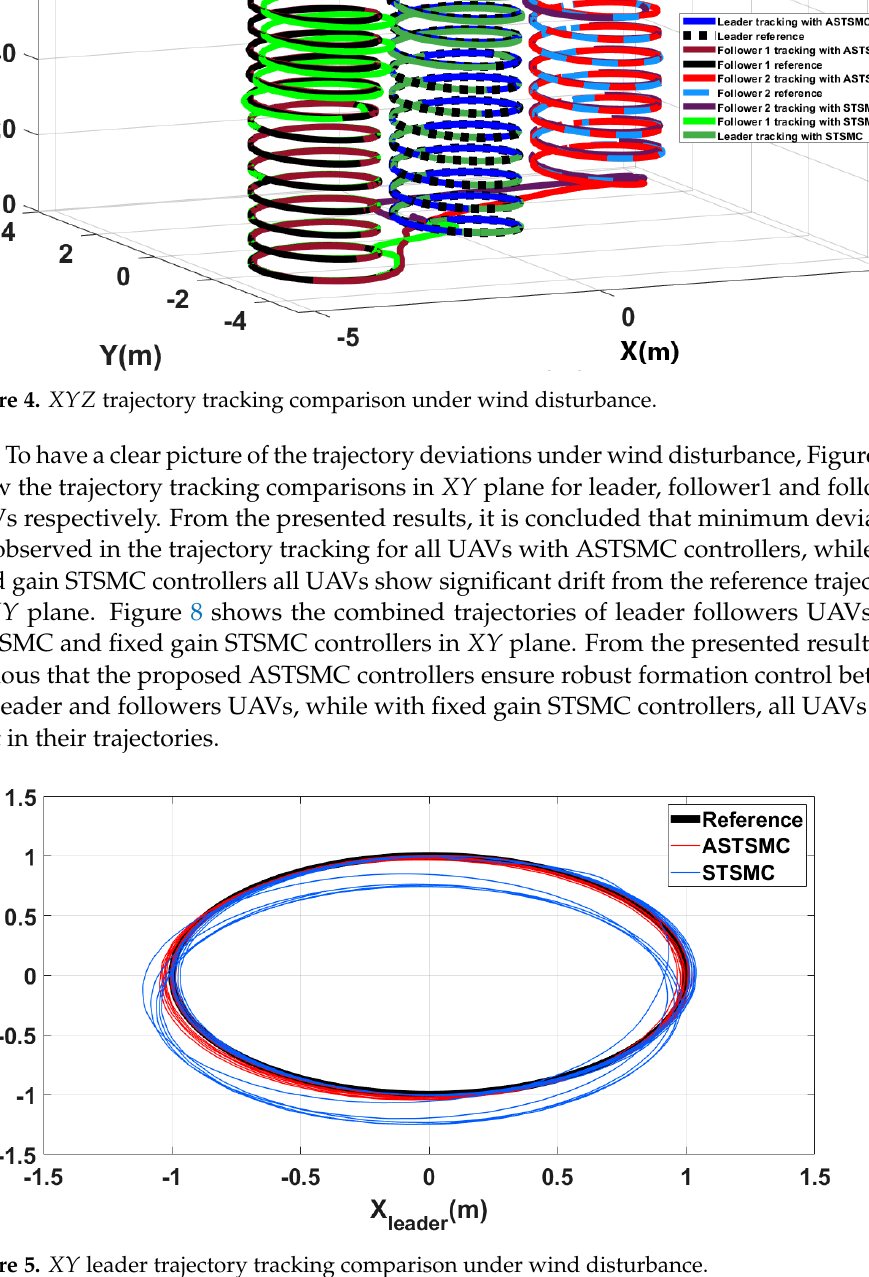
Figure 5. XY leader trajectory tracking comparison under wind